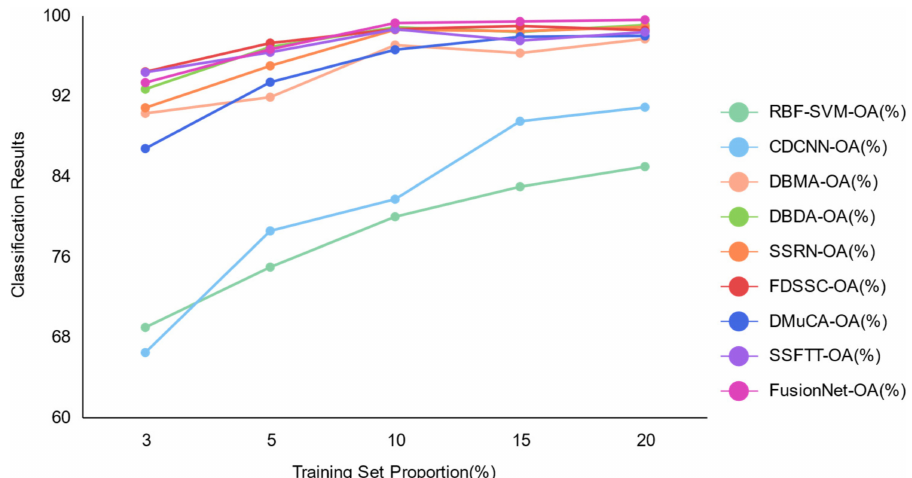
Figure 16. Effect of training set size on classification